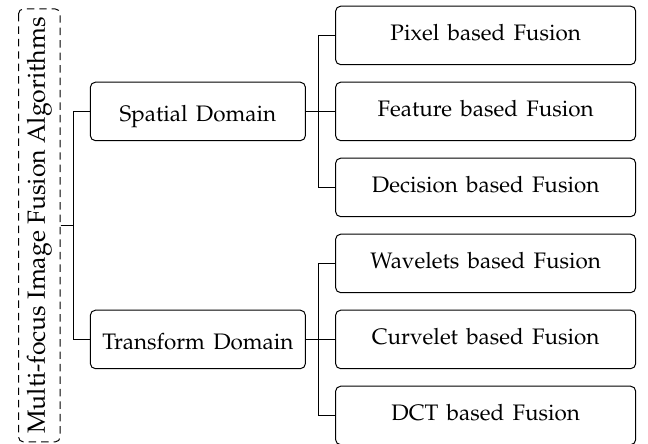
Figure 2. Categorization of multi-focus image fusion algorithms. The algorithms are divided into two main categories: Spatial domain based algorithms and Transform domain based algorithms, which are divided into further sub-categories. Spatial domain based algorithms: Pixel based Fusion [20,34,45–60], Feature based Fusion [21,24,33,61], Decision based Fusion [39,62–64]. Transform domain based algorithms: Wavelets based Fusion [24,40,44,56,65,66], Curvelet based Fusion [18,44], DCT based Fusion